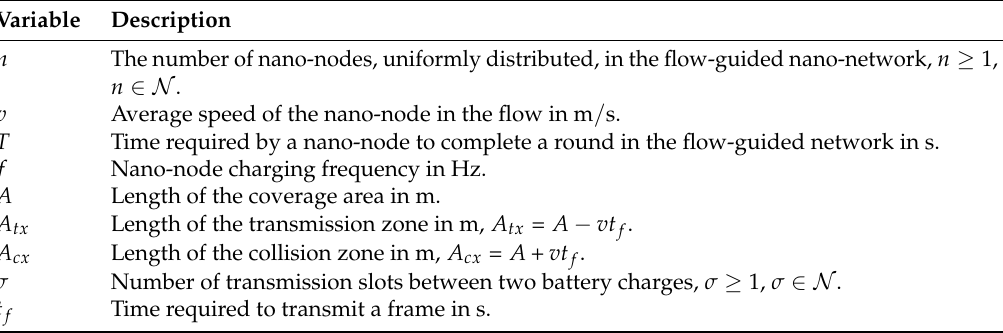
Figure 1. Scenario in which transmissions from Nano-Nodes A and B collide. The upper part of the figure represents the initial state at t 0 (Nano-Node A within the transmission zone and Nano-Node B within the collision zone; i.e., transmissions do not collide yet). The lower part of the figure represents the final state after the transmissions end at t 0 + t f (Nano-Nodes A and B within the transmission zone; i.e., a collision occurs). Table 1 specifies all the variables used in this analytical model. Table 1. Variables used in the analytical model and their